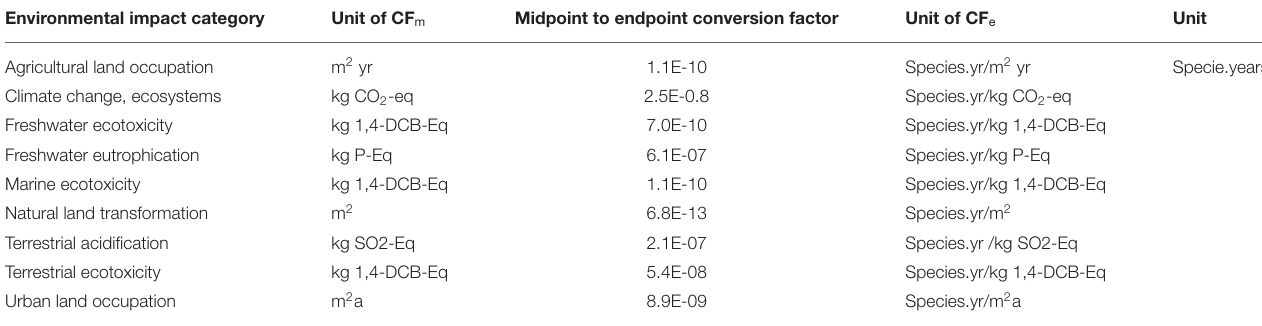
TABLE 3 | ReCipe impact category indicators, conversion factors, and units of conversion used in this study. Environmental impact